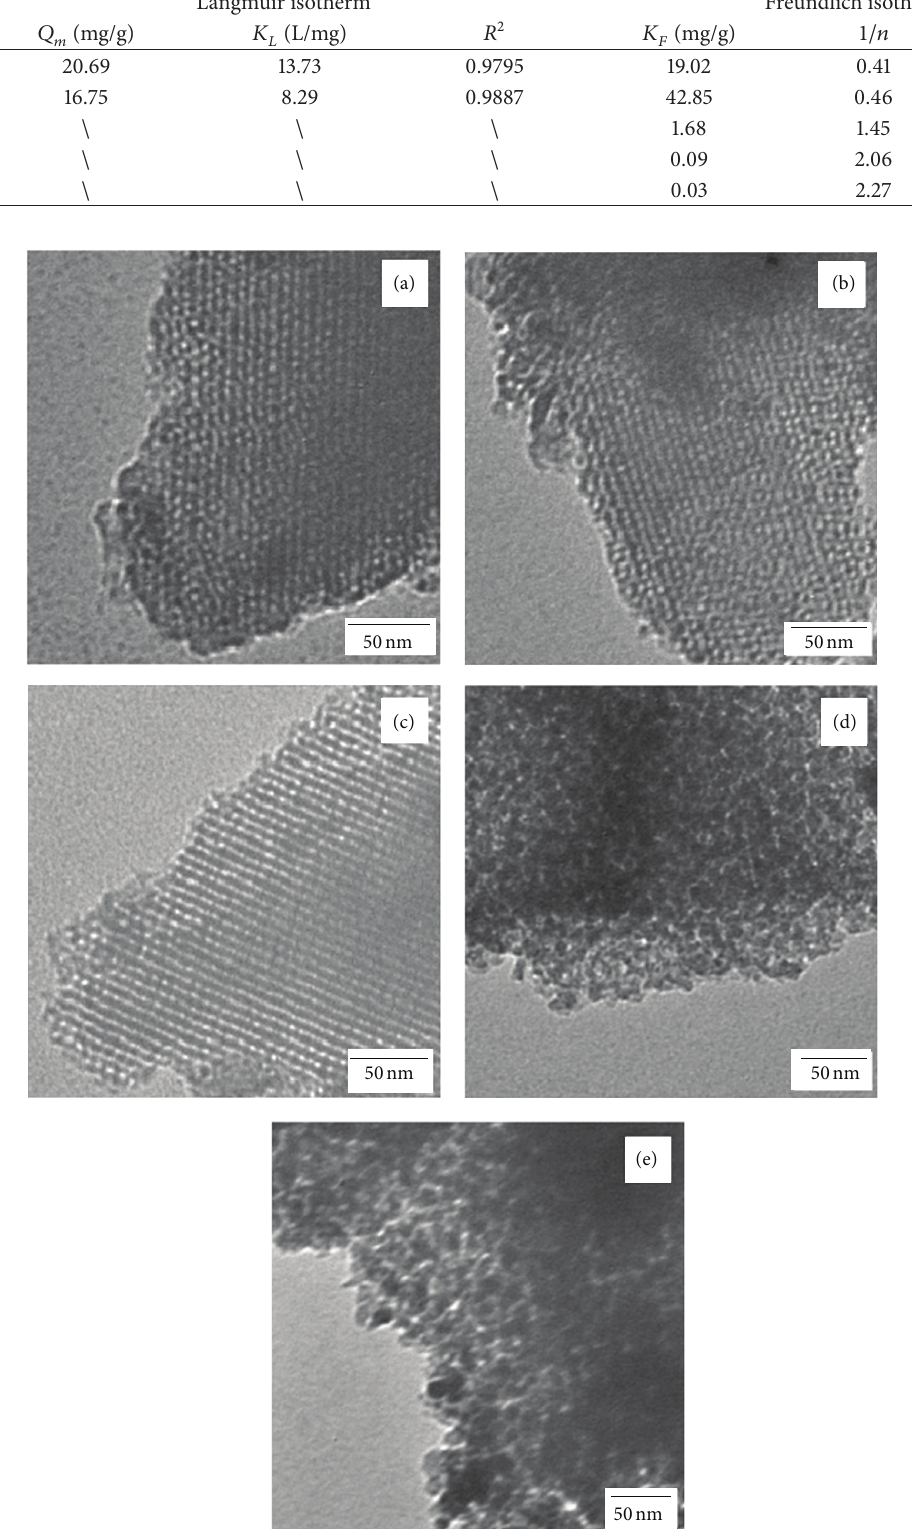
Figure 12: TEM images of regeneration products ((a) BG-La-1, (b) BG-La-2, (c) BG-La-3, (d) BG-La-1, and (e)